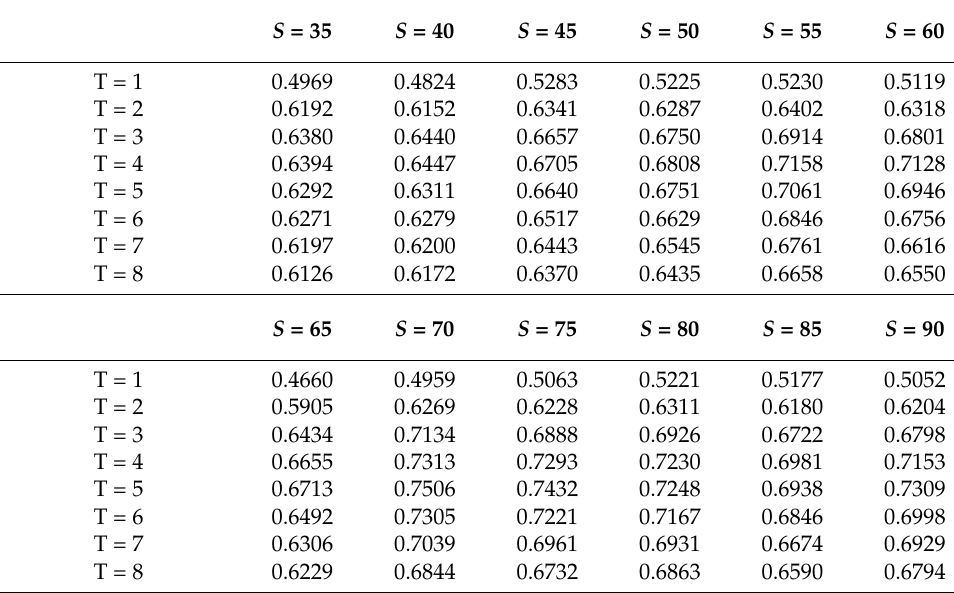
Table A13. The IoU of PSPnet varies with sampling size S and threshold level